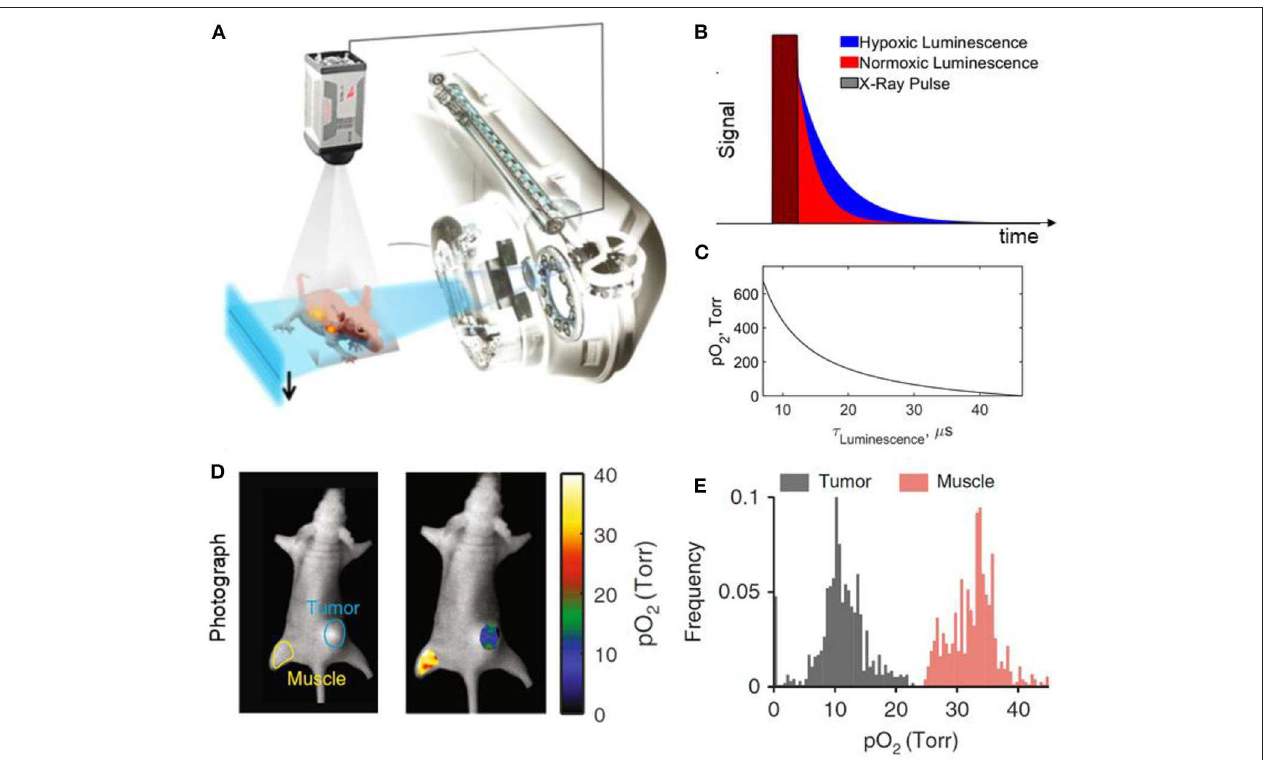
FIGURE 13 | Cherenkov excited luminescence imaging of oxygen concentration; (A) Schematic of a 6MV x-ray beam from the linear accelerator used to excite luminescence and captured by a time-synchronized camera; (B) Time signatures of the x-ray pulse and the imaged luminescence in hypoxic and normoxic tissue; (C) Relation between pO 2 pressure and luminescent lifetime based on Stern-Volmer model; (D) pO 2 map of muscle and tumor tissue with their respective histograms shown in (E) . Figure adapted from Zhang et al., Bruza et al., and Cao et al.